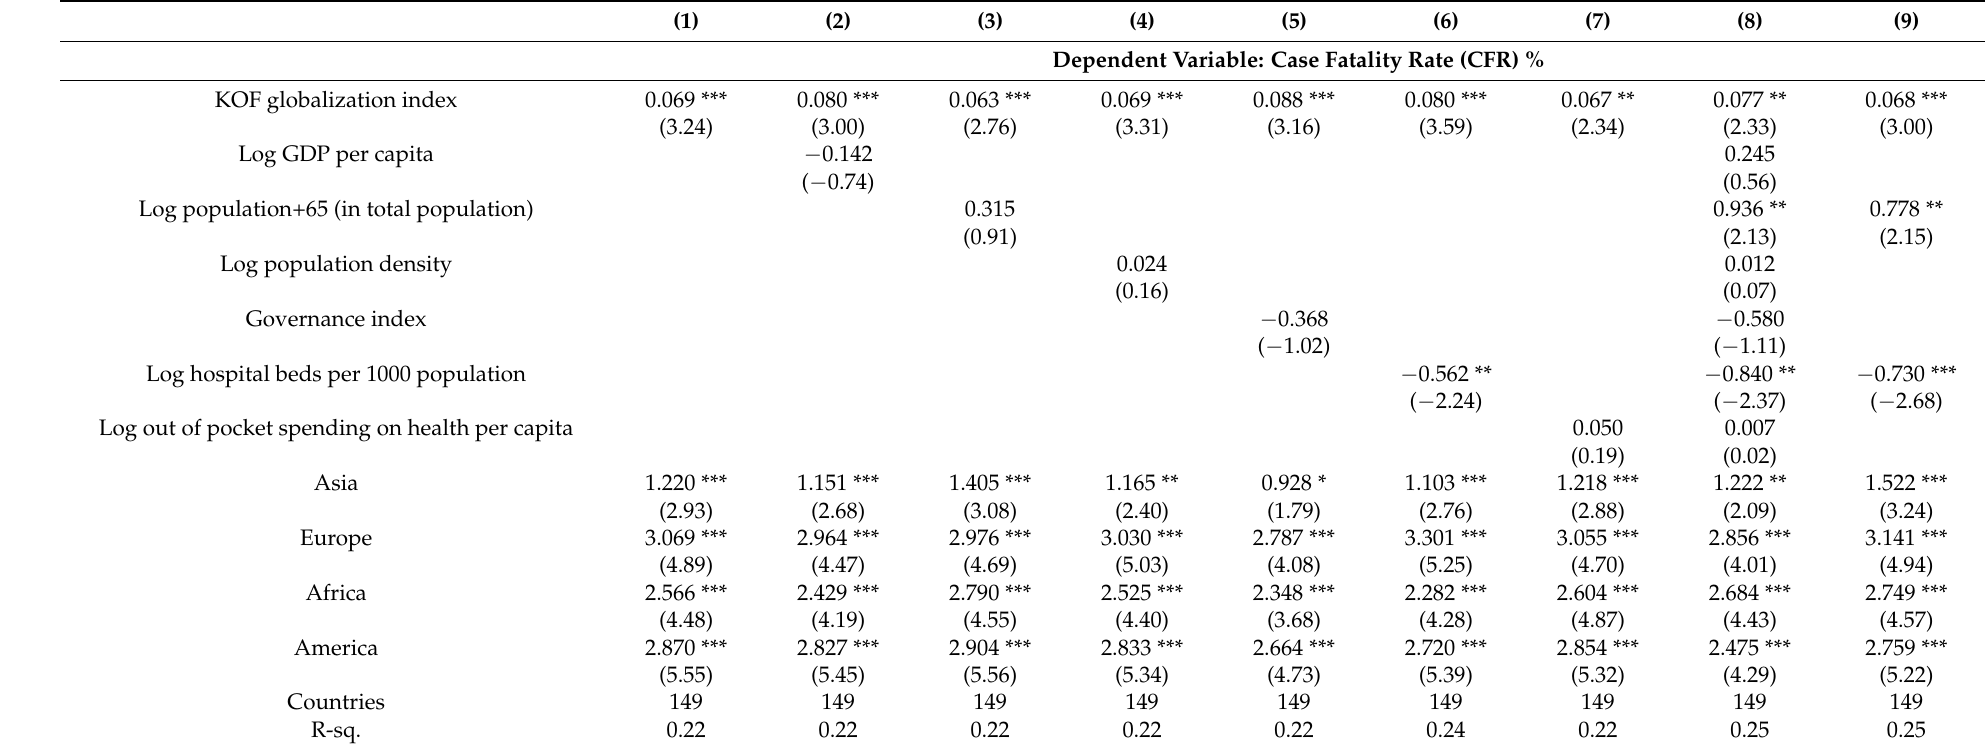
Table 2. Case fatality rate and